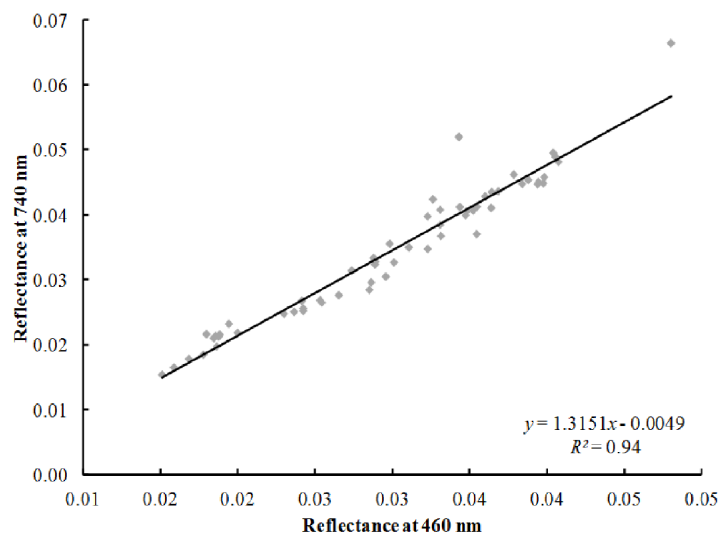
Figure 5. Relationship between 740 nm and 460